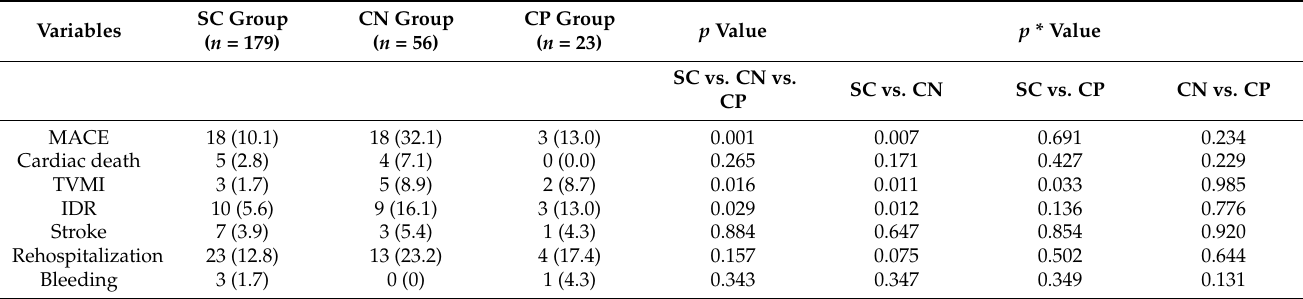
Table 4. Clinical outcomes.